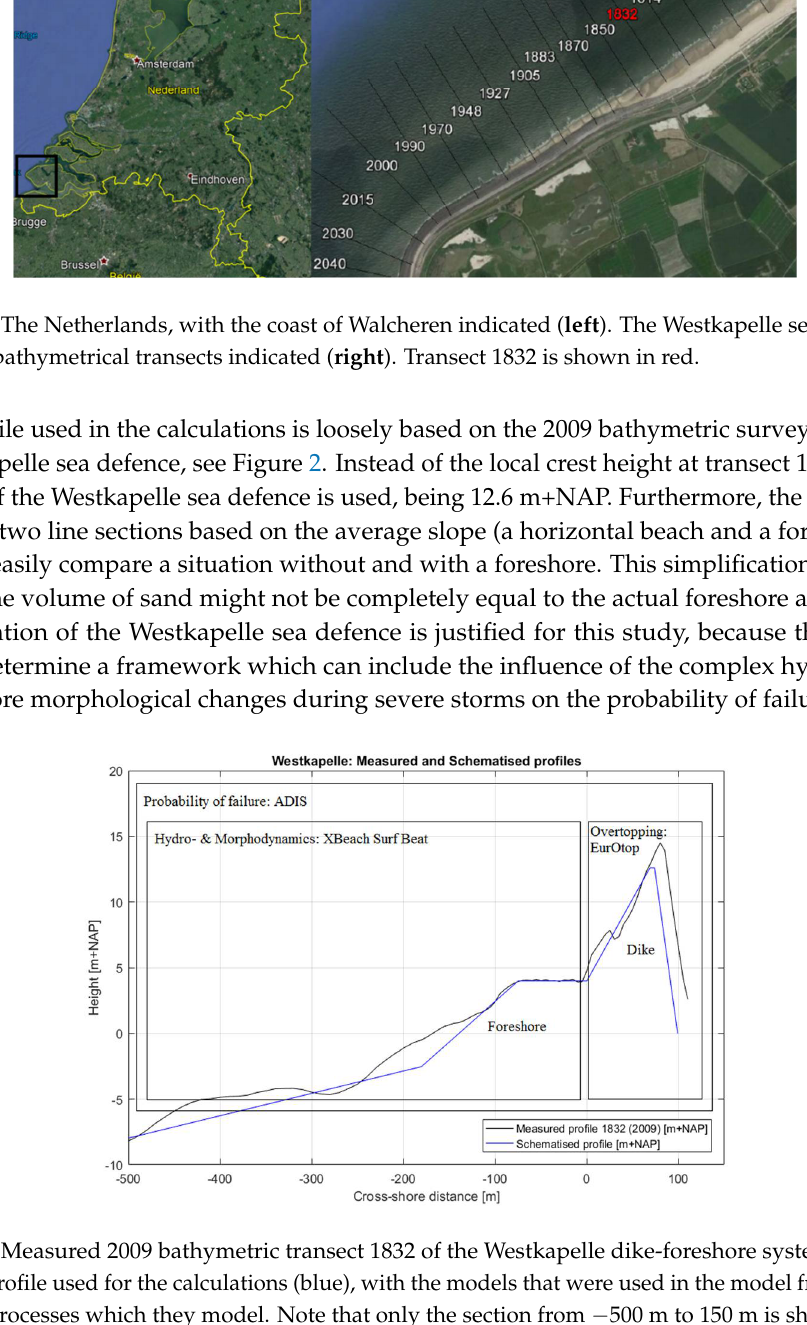
Figure 2. Measured 2009 bathymetric transect 1832 of the Westkapelle dike-foreshore system (black) and the profile used for the calculations (blue), with the models that were used in the model framework and the processes which they model. Note that only the section from −500 m to 150 m is shown.